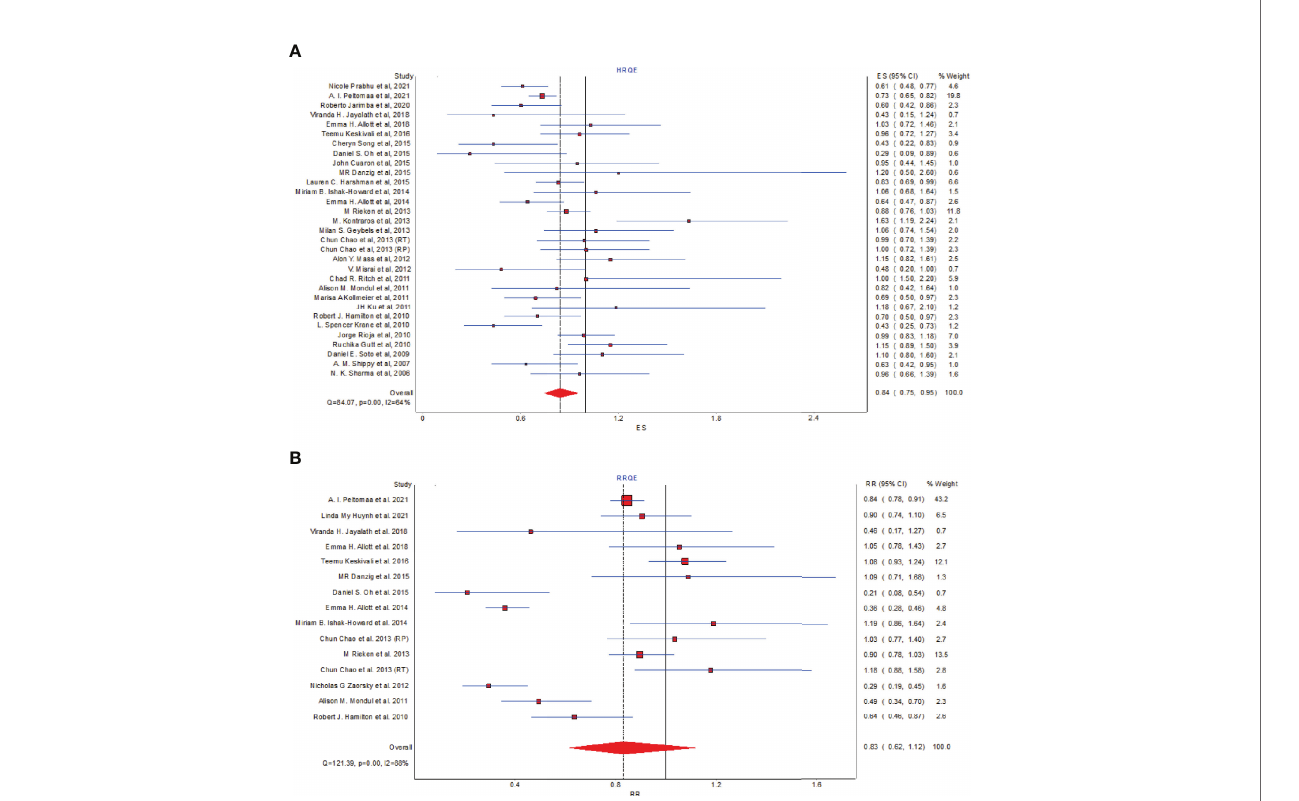
FIGURE 6 | The effect of statins on BCR risk of prostate cancer among men following de fi nitive therapy using the quality effects model. (A) Forest plot for the HR of BCR. (B) Forest plot for the RR of